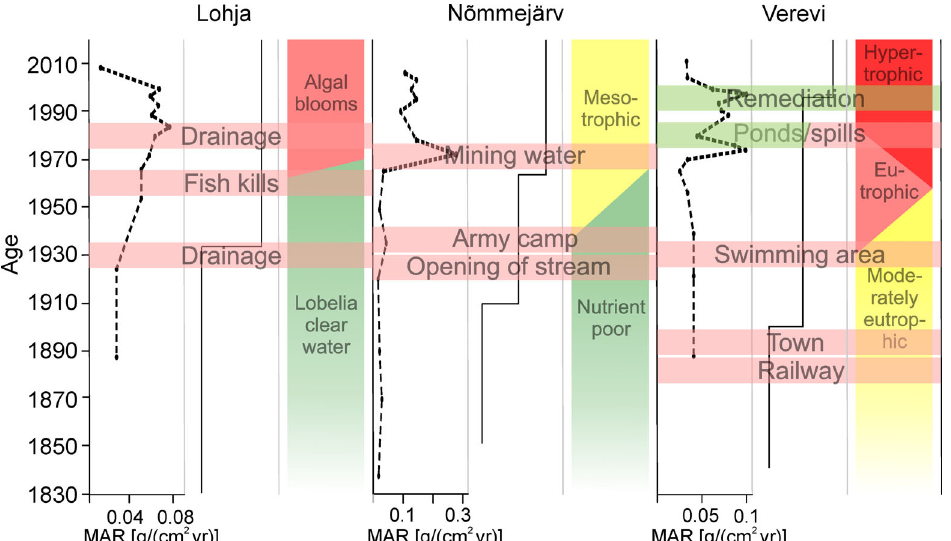
Fig. 6. Summary of our analysis of mass accumulation rates (MAR) of sediments (dashed line). Main zones of CONISS stratigraphical cluster analysis showed periods of different environmental conditions based on the data (solid line). The principal disturbances historically present (pink colour) for different lakes, such as drainage and fish kills for Lake Lohja (Marzecová et al. 2016), building of new streams, presence of army camps and discharge of mining waters for Lake Nõmmejärv (Marzecová et al. 2011) and the establishment of a railway, town and swimming area, as well as spills from ponds for Lake Verevi (Mikomägi et al. 2016). The periods of remediation measures for Lake Verevi are shown in green colour. The description of the ecological status of lakes is based on lake monitoring data (Ott